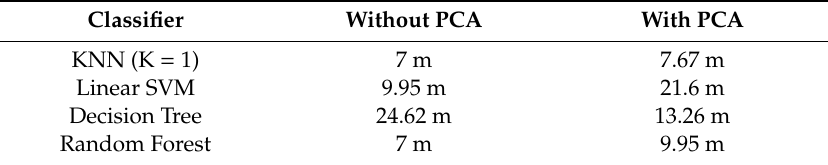
Table 2. The CDF Error at